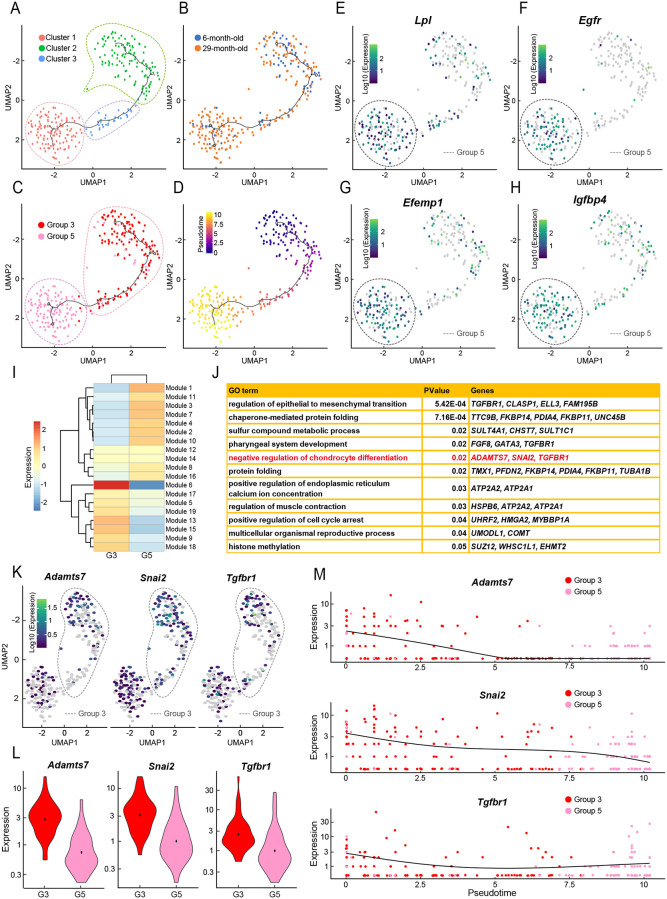
Pseudotime analysis using Monocle 3.(A-D) The data of Group 3 (cell number, n = 136) and Group 5 (cell number, n = 134) from young and old mice were reanalyzed using Monocle 3. Black lines in the plot show the paths of pseudotime. UMAP plots are colored according to three clusters (A), age (B), groups (C), and pseudotime (D). (E-H) Heat maps showing the Log10 expression levels of Lpl, Egfr, Efemp1, and Igfbp4 in the UMAP plot. Gray dotted lines indicate the Group 5 area. (I) The heat maps of the hierarchical cluster analysis and expression of modules between Group 3 (G3) and Group 5 (G5) are shown. The modules consist of genes clustered according to the correlation of expression levels. Genes whose expression changed significantly over pseudotime were extracted using Moran’s I test for spatial autocorrelation (q-value < 0.05). (J) GO terms of module 6 genes searched using DAVID (p-value < 0.05). (K) Heat maps showing the Log10 expression levels of Adamts7, Snai2, and Tgfbr1 in the UMAP plot. Gray dotted lines indicate the Group 3 area. (L) Violin plots showing the distribution of Adamts7, Snai2, and Tgfbr1 expression in Group 3 (red) and Group 5 (magenta). (M) Kinetic plots showing the expression of Adamts7, Snai2, and Tgfbr1 over pseudotime are shown.